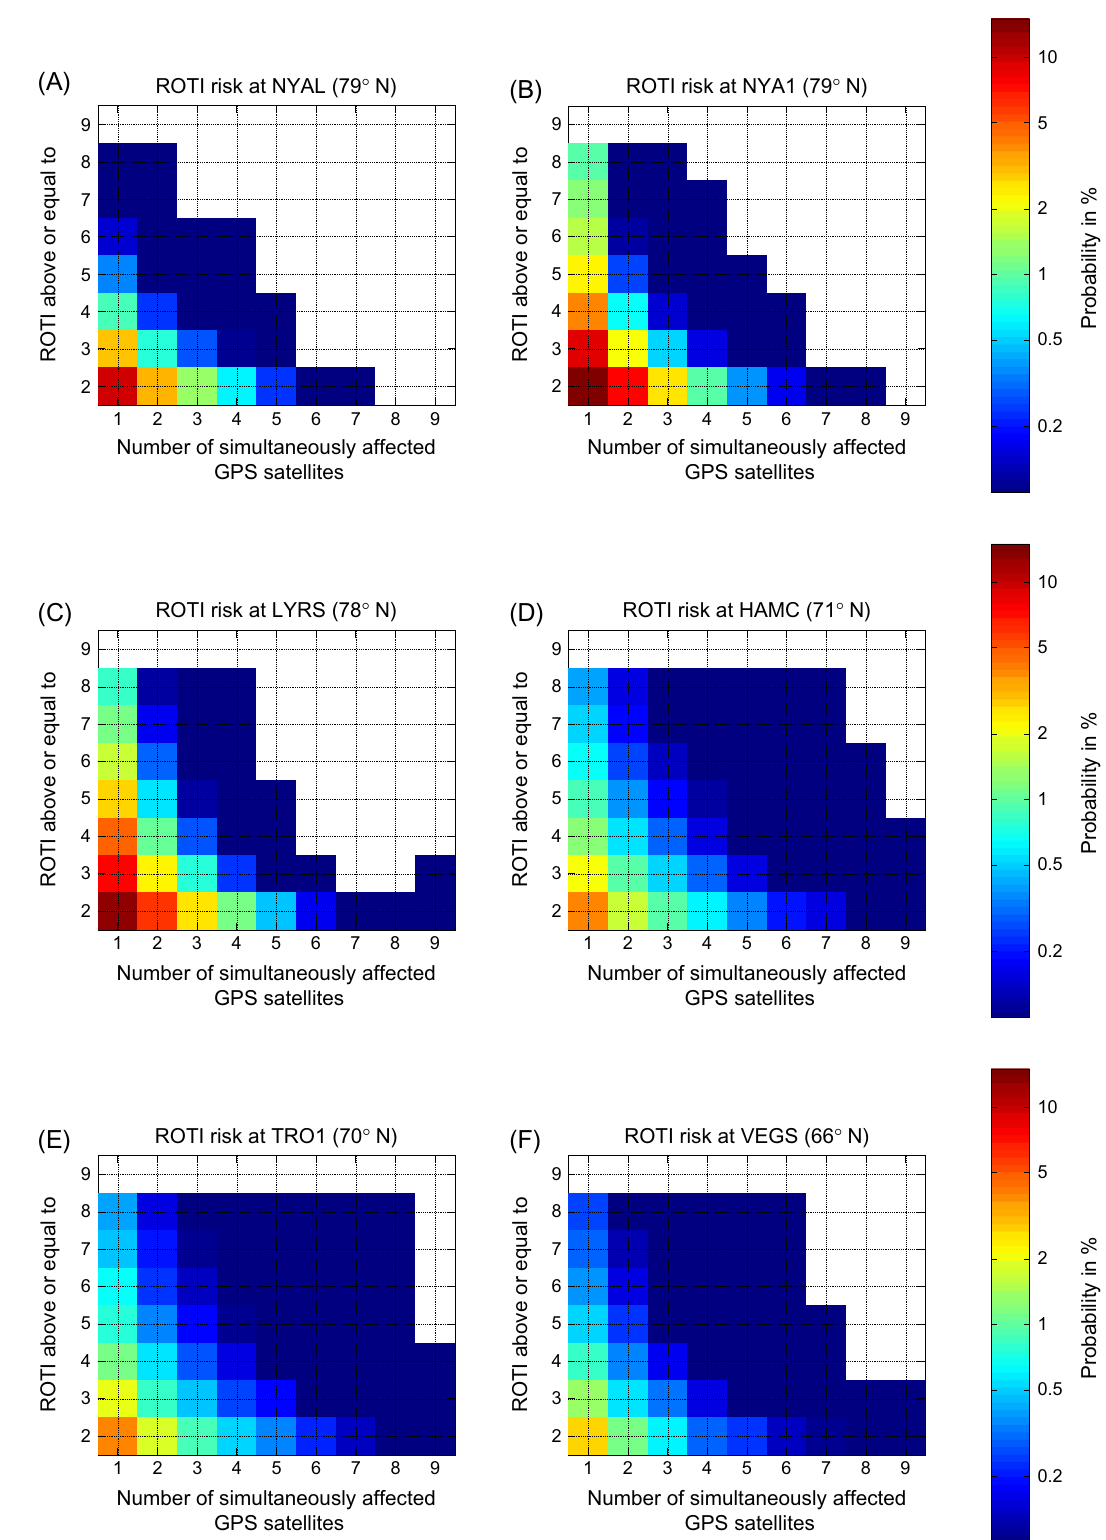
Fig. 11. Tables of the probabilities that ROTI exceeds threshold values simultaneously at several satellites, for these receivers: (A) NYAL, (B) NYA1, (C) LYRS, (D) HAMC, (E) TRO1, (F) VEGS.